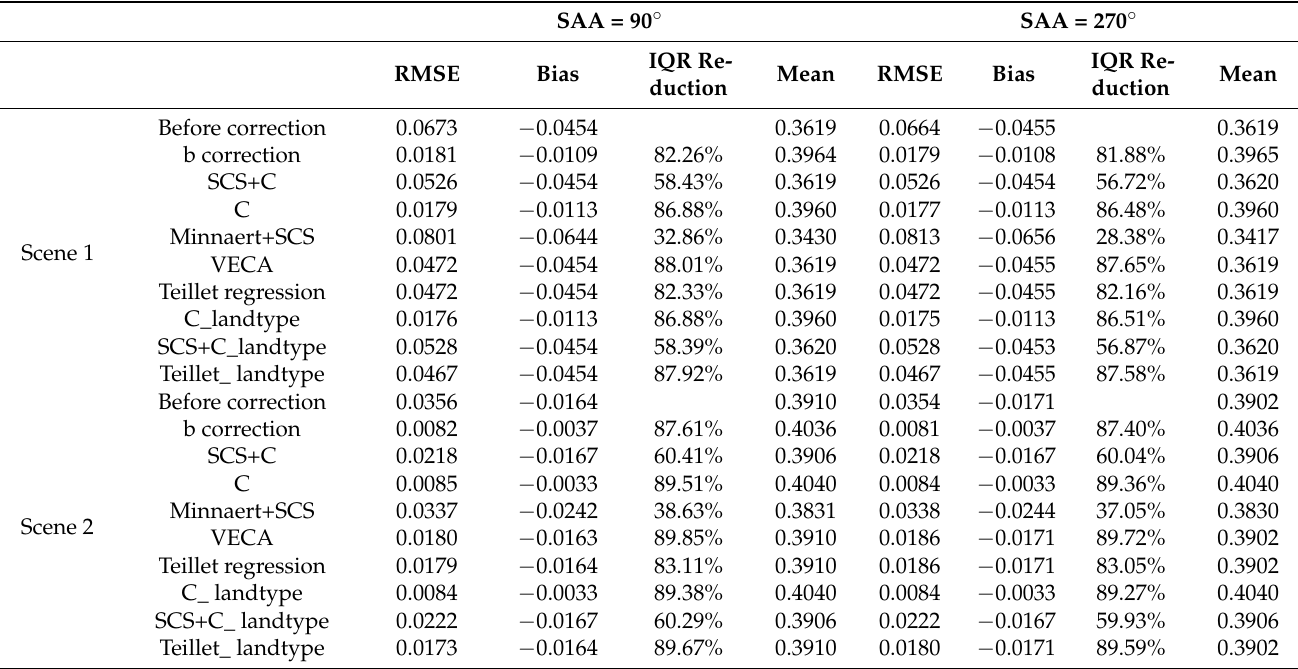
Table 4. The comparison of topographic correction methods in different simulated